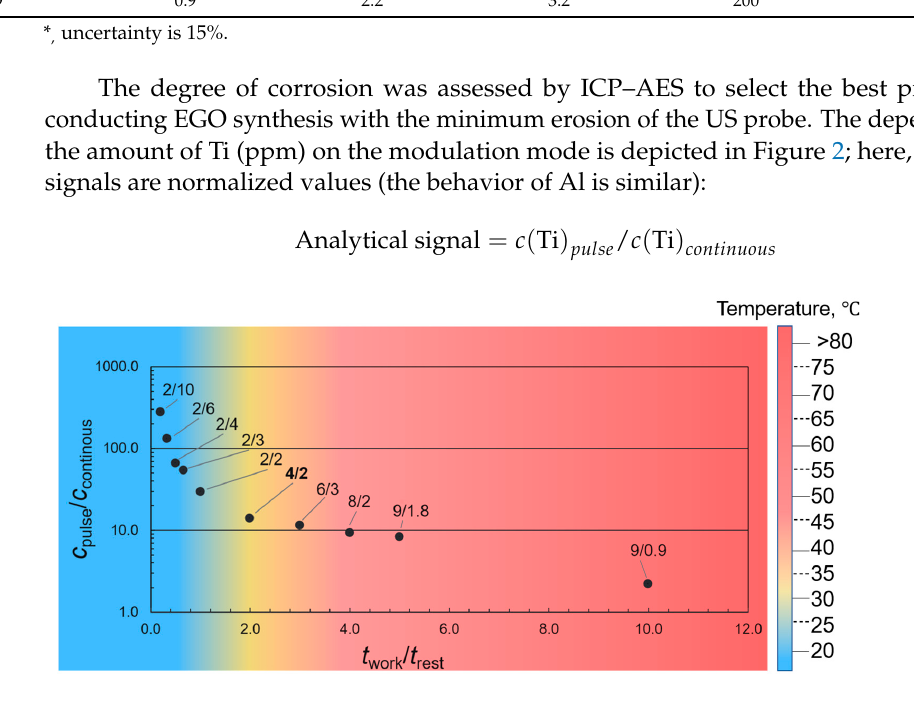
Figure 2. The concentration of Ti in the modulation mode normalized to the continuous mode. The temperature measurement error is about ±5 °C.